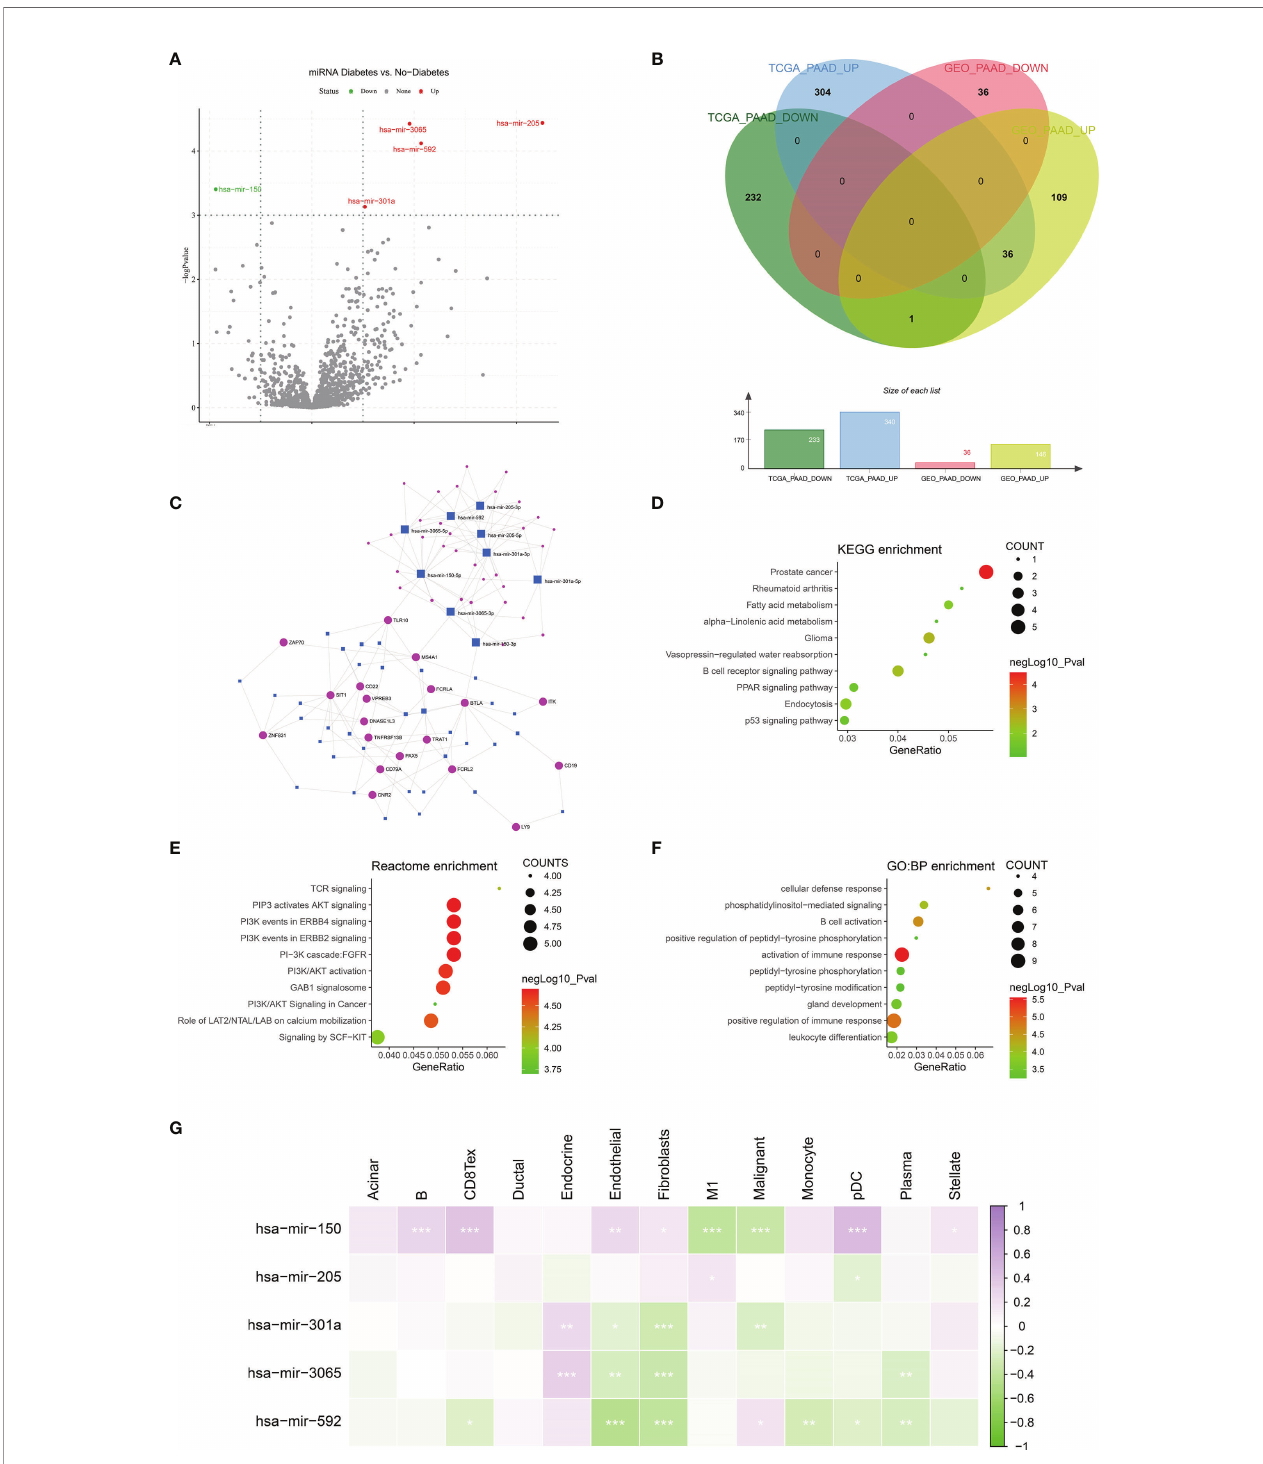
FIGURE 7 | Construction of miRNA-mRNA regulatory network. (A) Differential expression analysis was performed on the Diabetes and no-diabetes subgroups of the TCGA PAAD miRNA dataset to fi nd miRNAs that were signi fi cantly different between the two groups. (B) Screening of the intersection of differentially expressed genes from the TCGA PAAD dataset and the GSE79668 dataset. 36 genes that were highly expressed in pancreatic cancer diabetic patients were screened. genes were screened out. (C) Construction of miRNA-mRNA network interactions maps based on differentially expressed miRNAs and mRNAs. (D – F) Functional enrichment analysis of miRNA-mRNA regulatory networks. miRNA-mRNA networks are functionally enriched, mainly in immune and cancer-related signalling pathways. (G) The relationship between miRNAs and cellular in fi ltration in tumor microenvironment cells (Spearman correlation test, *p < 0.05, **p < 0.01, ***p <